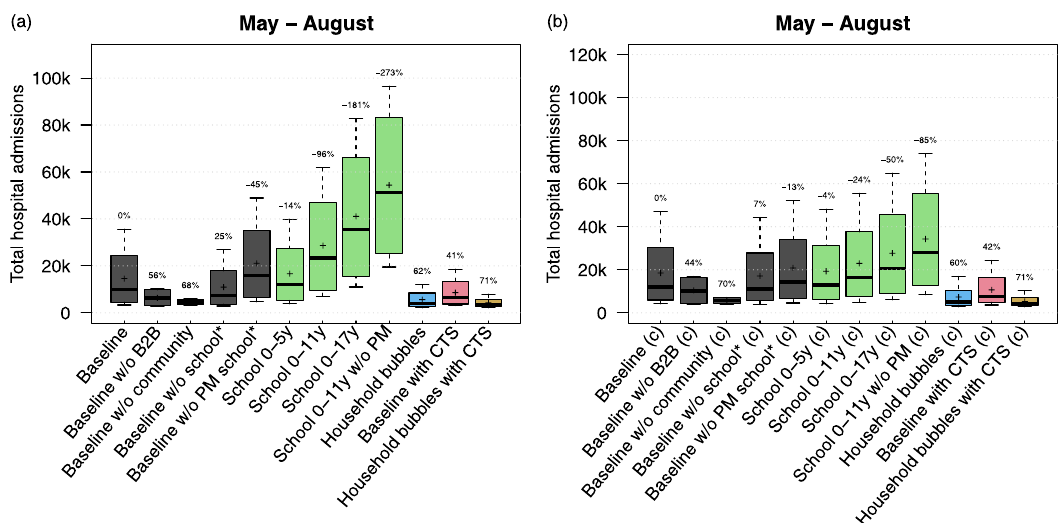
Fig. 5 Impact of location-speci fi c re-openings and age-speci fi c susceptibility. Total hospital admissions per scenario from May to August assuming that children between 0 and 17 years are equally susceptible as adults ( a ) or only half as susceptible compared to adults ( b ). The results are presented as the median (line), quartiles (box), 2.5 and 97.5 percentiles (whiskers) and average (cross) of 40 model realisations (i.e., ten stochastic runs for each of the four social contact behaviour assumptions). The percentages on top of the whiskers indicate the average reduction in hospital admissions with respect to the baseline. CTS contact tracing strategy, w/o without, PM precautionary measures at